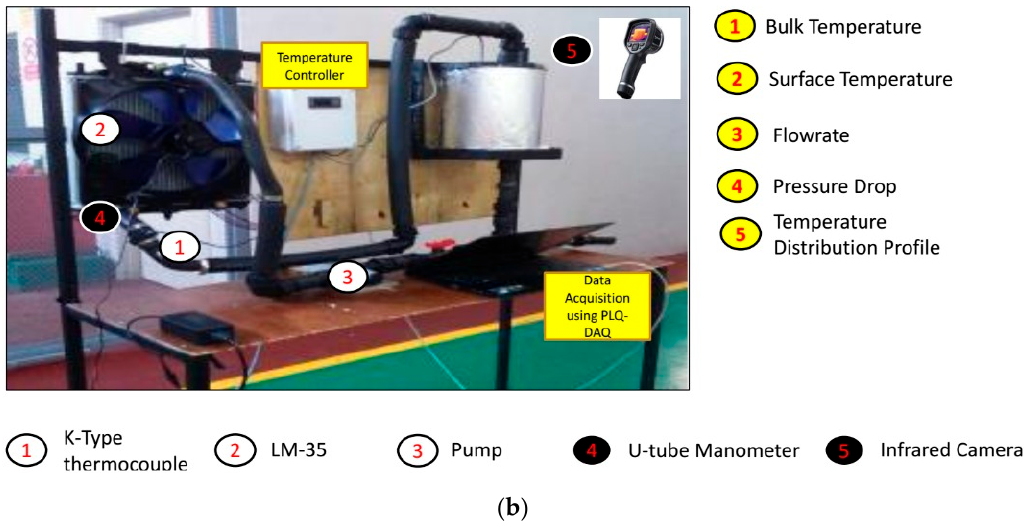
Figure 2. ( a ) Schematic diagram of the radiator test rig, ( b ) Experimental set ‐ up of the radiator test rig. Parallax Data Acquisition tool (PLQ ‐ DAQ); Integrated analog temperature sensor whose electrical output is proportional to Degree Centigrade (LM ‐ 35).